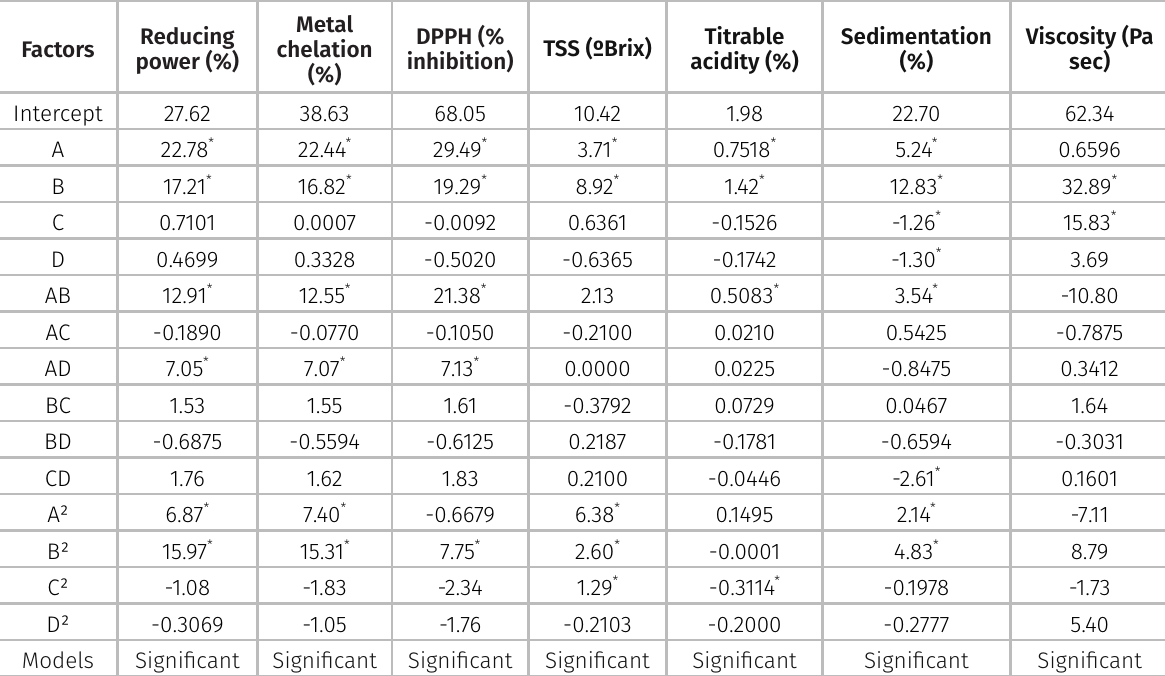
Table IV. Coefficient estimates of physiochemical properties for microgreen based functional juice.